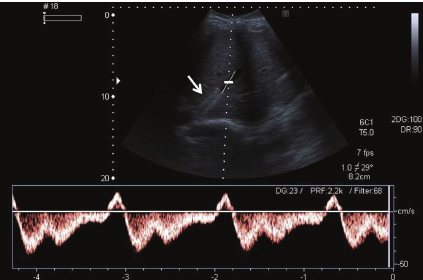
Figure 14: Spectral Doppler image posthepatic vein stenting demonstrates restoration of normal triphasic waveform (inverted “M” shape) of the right hepatic vein in a patient with BCS. Arrow denotes the stent in the right hepatic vein.